Question: Sum up the contents of this chart in one sentence.
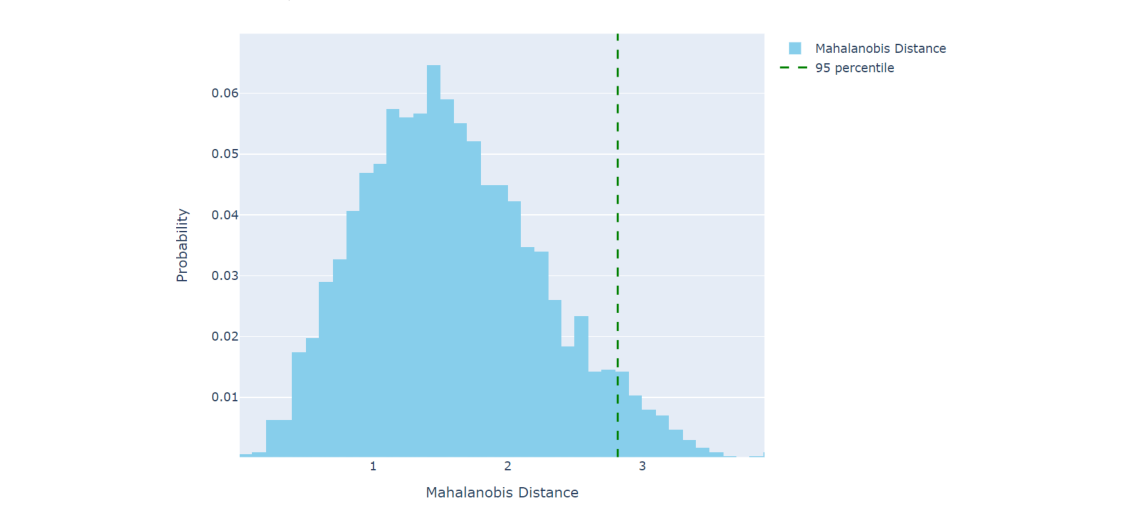
Answer: Mahalanobis distance for the ”In distribution” dataset